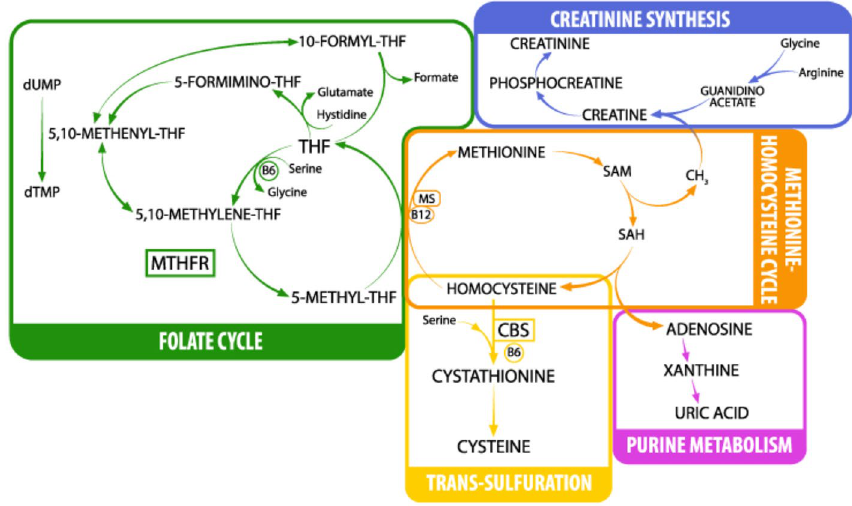
Figure 1. One-carbon metabolism. THF tetrahydrofolate, dUMP deoxyuridine monophosphate, dTMP deoxythymidine monophosphate, MTHFR methylene-tetrahydrofolate reductase, MS methionine synthase, SAM S-adenosylmethionine, SAH S-adenosylhomocysteine, CBS cystathionine beta-synthase. Image by Marcello